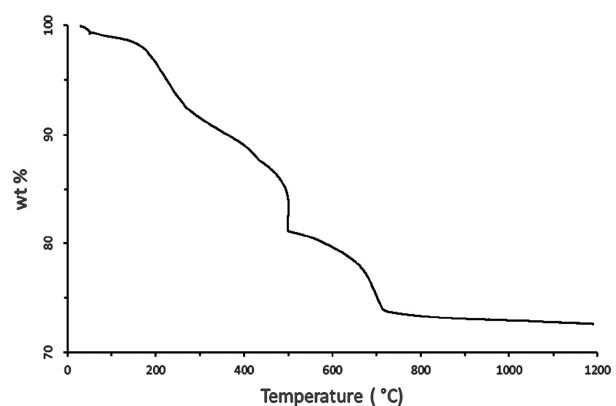
Figure 3. Thermogravimetric of the paste of the ceramic membrane. Membranes 2020 , 10 , x FOR PEER REVIEW